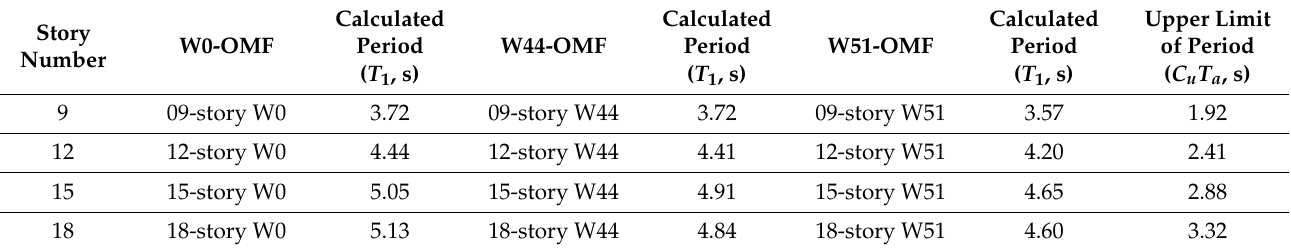
Table 1. Calculated fundamental period ( T 1 ) and upper limit of period ( C u T a ) according to ASCE 7-16 of the designed steel ordinary moment